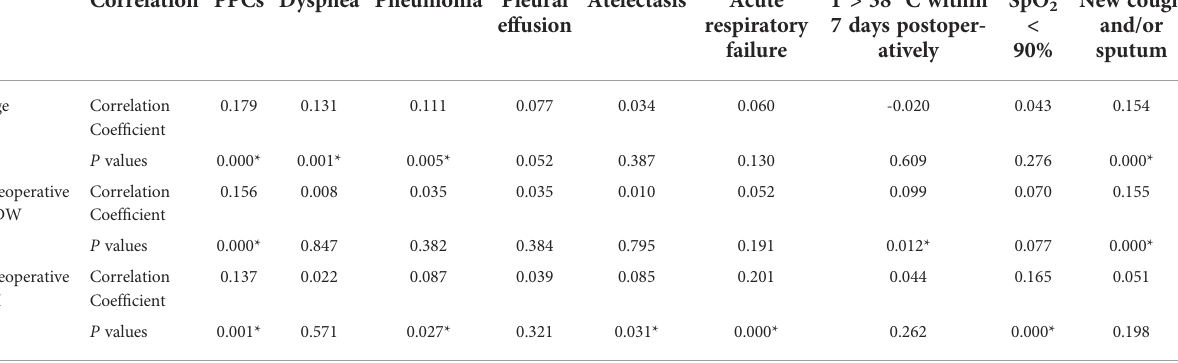
HGB, hemoglobin;ALB, albumin;RDW, red blood celldistribution width; NLRs,neutrophil to lymphocyteratios; PLRs, plateletto lymphocyteratios; SII, systemic immune-in fl ammation index; PPCs, pulmonary